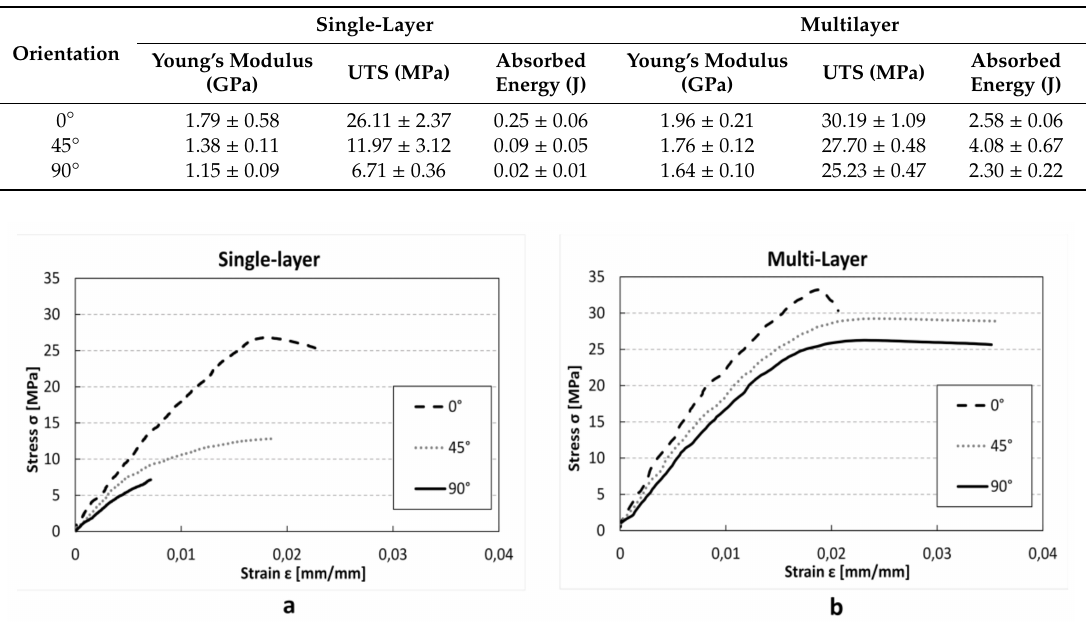
Figure 4. Representative quasi-static tensile tests for single ( a ) and multilayer ( b ) specimens at each raster